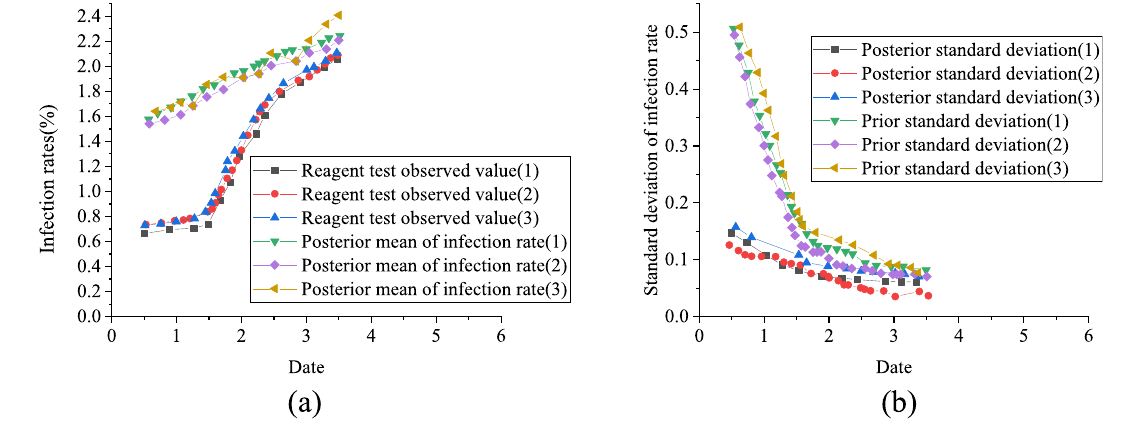
Figure 7. Statistical comparison of infection rate ( a ) the posterior mean of infection rate and the observation value of reagent detection; ( b ) the comparison of prior standard deviation and posterior standard deviation.